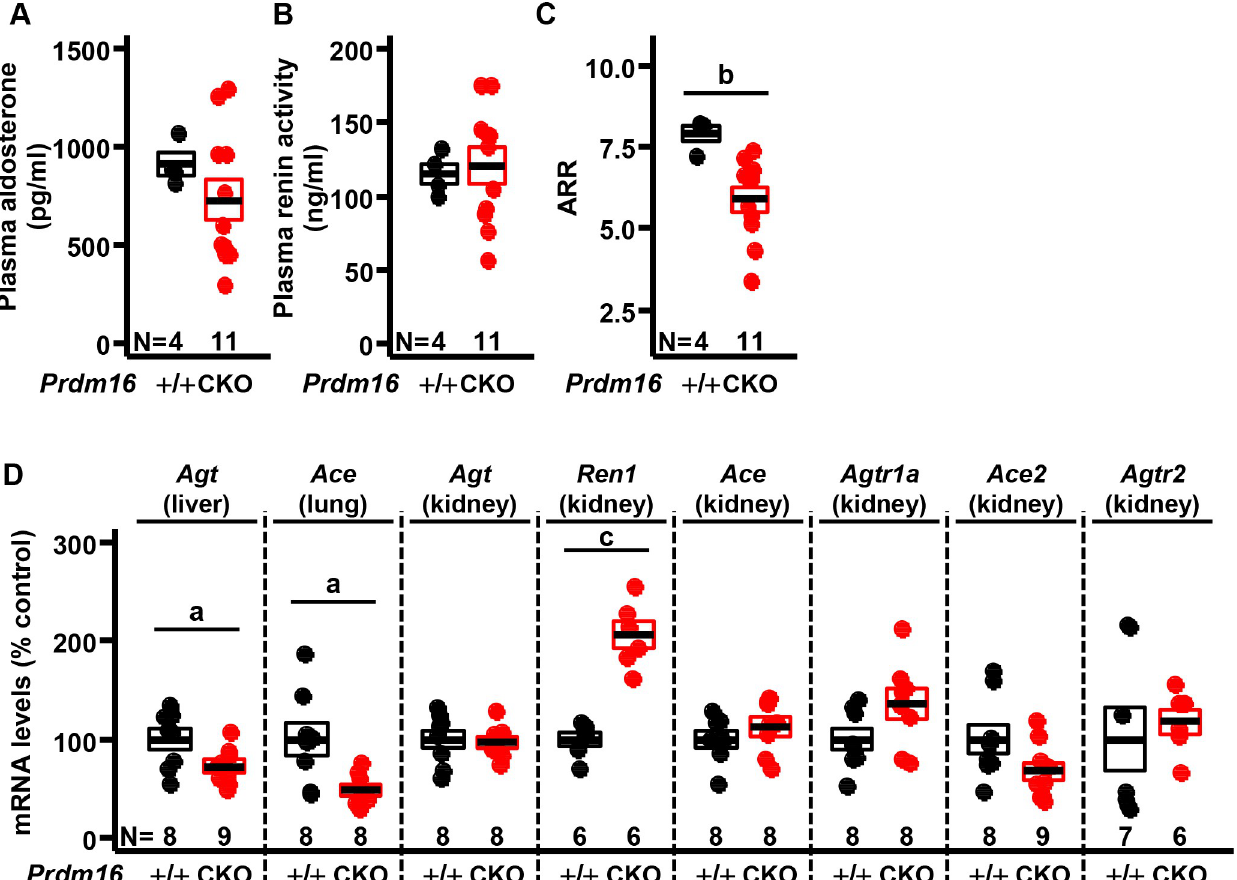
Fig 3. Changes in the renin-angiotensin-aldosterone system in female mice with cardiac-specific null mutation of Prdm16 . (A) Aldosterone levels, (B) renin activity, and (C) aldosterone-to-renin activity ratio (ARR) in plasma. (D) mRNA levels in liver, lung, and kidney for components of the renin- angiotensin system. Error bars, mean ± SEM; number (N), number of mice; statistical significance by student’s t -test, a ( P < 0.05), b ( P < 0.01), and c ( P < 0.005).